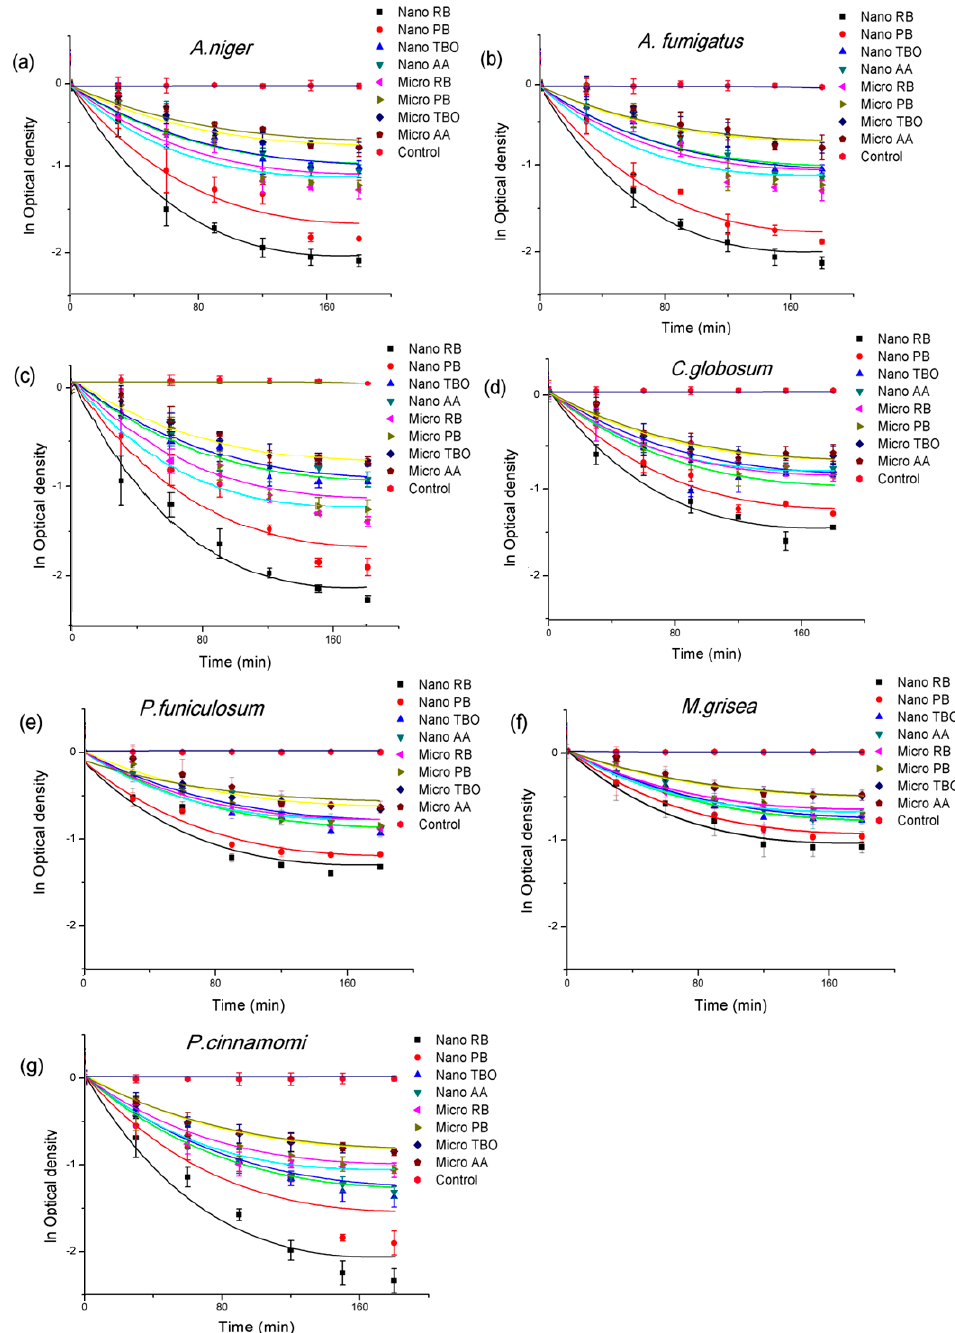
Figure 4. The optical density (OD) reduction by nano and micro fabrics grafted with RB, PB, TBO, and AA graphed as a function of time under illumination on ( a ) A. niger ; ( b ) A. fumigatus ; ( c ) T. viride ; ( d ) C. globosum ; ( e ) P. funiculosum ; ( f ) M. grisea ; and ( g ) P. cinnamomi. Note: all axes are to the same scale to aid comparisons between materials.